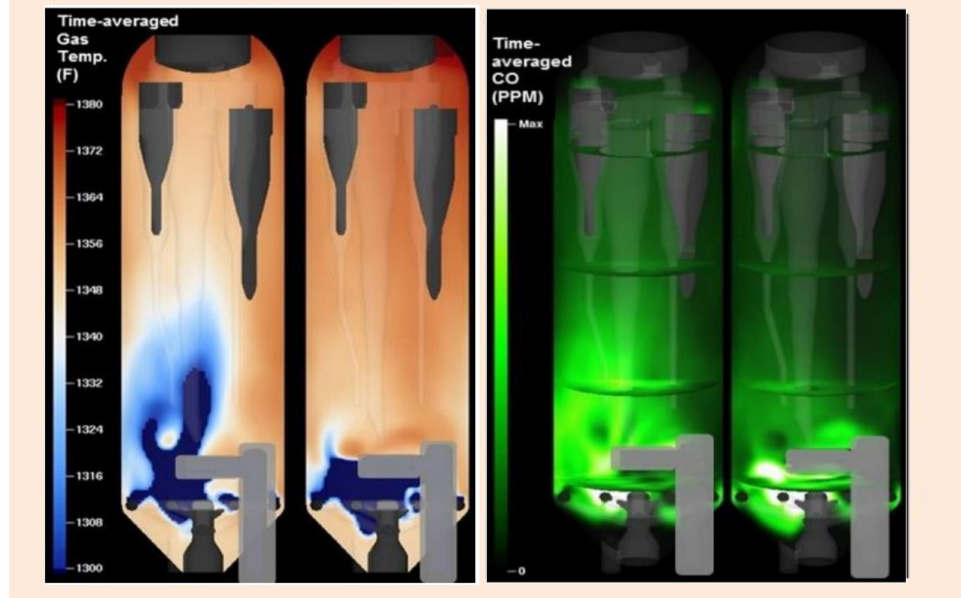
Figure 15. Effect of spent catalyst distributor on regenerator performance. ( Left ): old spent catalyst distributor. ( Right ): new distributor with new design. Adopted from Parker and Blaser